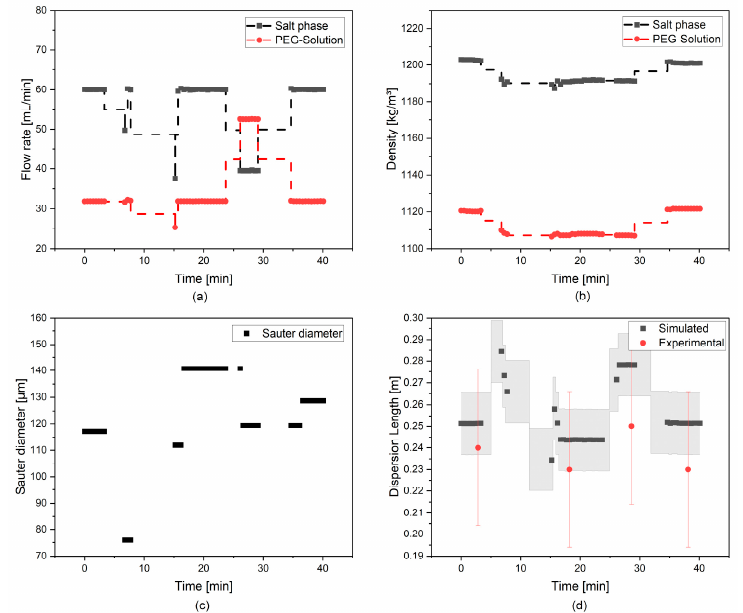
Figure 23. Plot of measured volumetric flow rate ( a ), density ( b ), Sauter diameter ( c ), and simulated and measured wedge length from aqueous ATPE experiment ( d ).